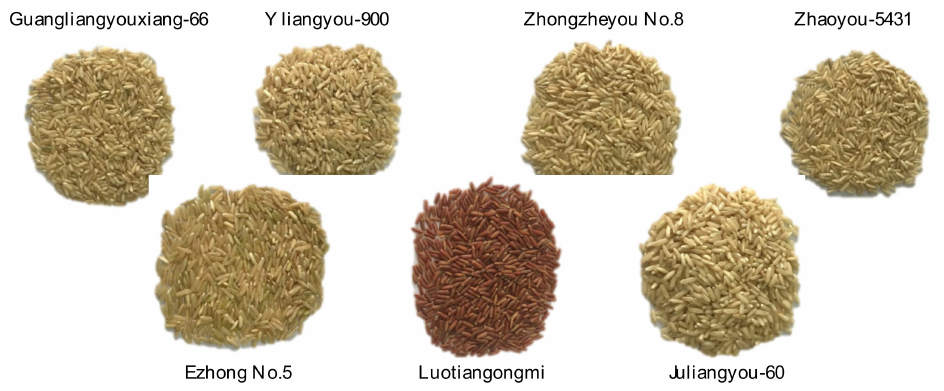
Figure 2. Appearance pictures of different varieties of brown rice cultivated in Hubei